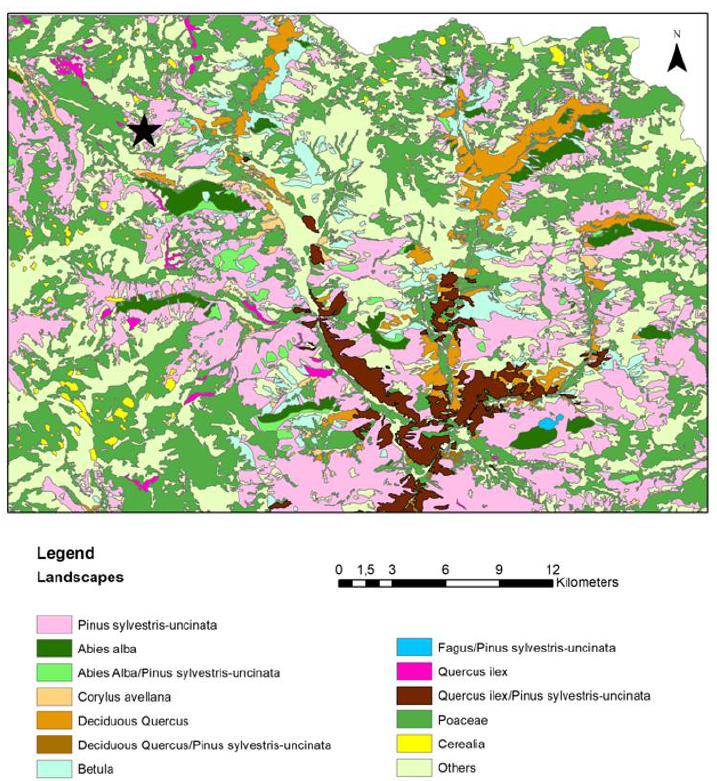
Figure 2. Vegetation map of the Clots de Rialba peat bog area. Source: Own elaboration based on cartographic bases of the habitats of Catalonia. Department of Climate Action, Food and Rural Agenda. Catalan Government.